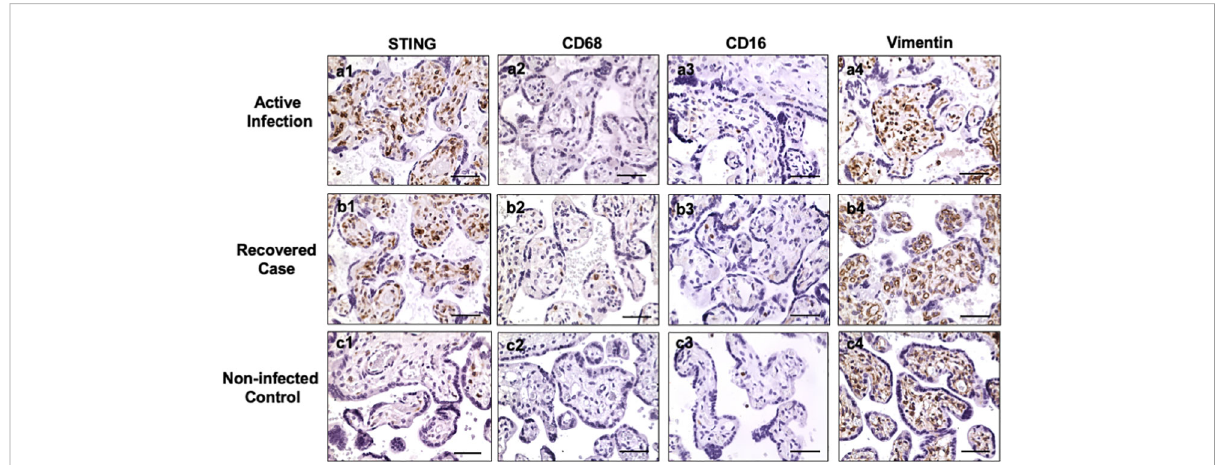
FIGURE 2 STING, CD68, CD16, and vimentin expression in villous tissue of placentas with or without exposure to maternal COVID-19 infection. Active infection: from placentas delivered by women with positive detection of SARS-COV-2 RNA when admitted to Labor and Delivery. Recovered case: from placentas delivered by women with positive detection of SARS-COV-2 RNA at second trimester and negative detection of SARS- COV-2 RNA when the patient was admitted to hospital for delivery. Non-infected control: from placenta delivered by women who was never infected with COVID-19 before and during pregnancy. STING is strongly expressed in villous stromal cells in both active infection (a1) and recovered (b1) cases, but only a few positive cells were seen in villous stromal in non-infected control (c1) placentas. Both CD68 and CD16 are markers for macrophages. Only a few positive CD68 and CD16 cells were detected in villous stromal in active (a2, a3), recovered (b2, b3), and control (c2, c3) placentas. Vimentin is a marker of mesenchymal cells. Vimentin positive cells were detected in villous stroma in all villous tissue examined: active infection (a4), recovered (b4), and non-COVID control (c4) placentas. These results indicate that STING positive cells are villous mesenchymal stromal cells (MSCs), not Hofbauer cells (macrophages), in placentas exposed to COVID infection. Bar =